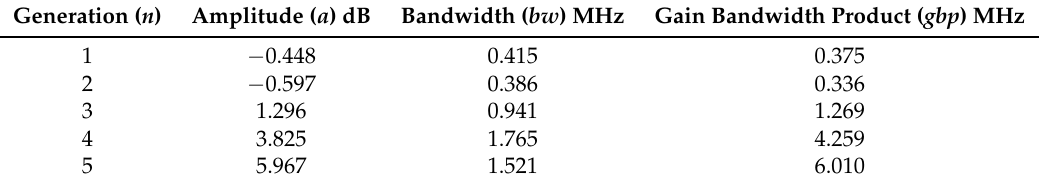
Table 2. Figures of merit for the Sierpinski tetrix pre-fractal sensors at generation levels one to five, where the bandwidth is calculated using the amplitude at the resonant frequency for fractal generation level